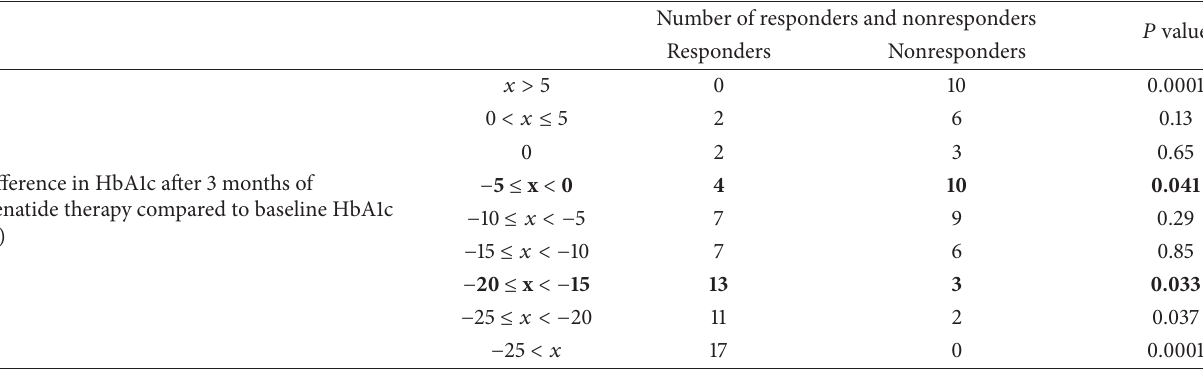
Table 4: Contingency table quantifying the percentage change in HbA1c after 3 months of exenatide therapy from baseline against the proportion of participants who went on to respond and not to respond to exenatide by 6